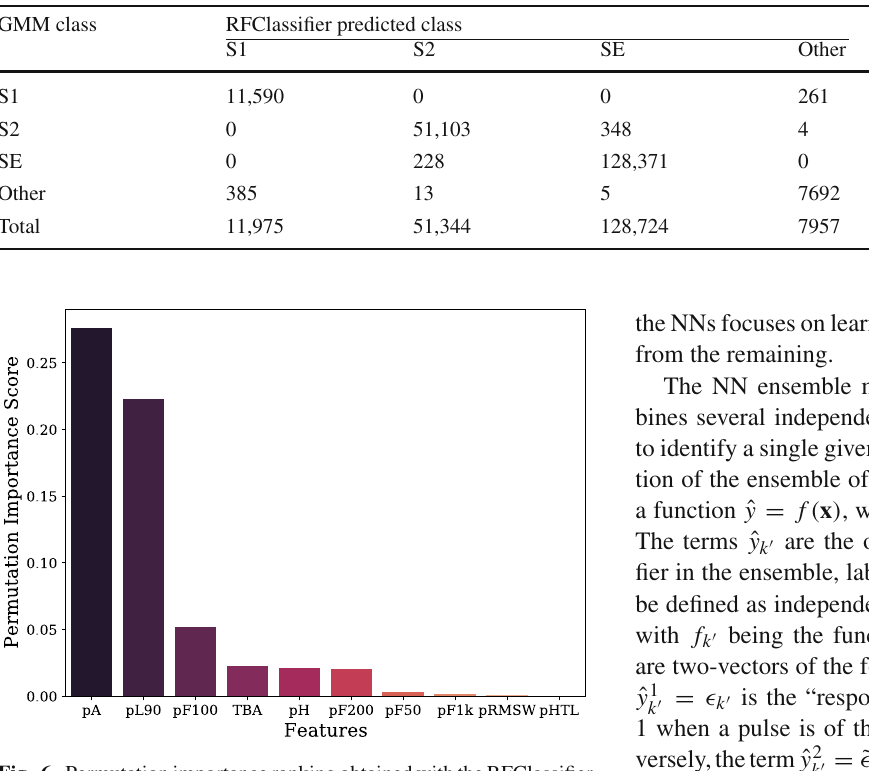
RQs scored the lowest on the permutation importance rank-